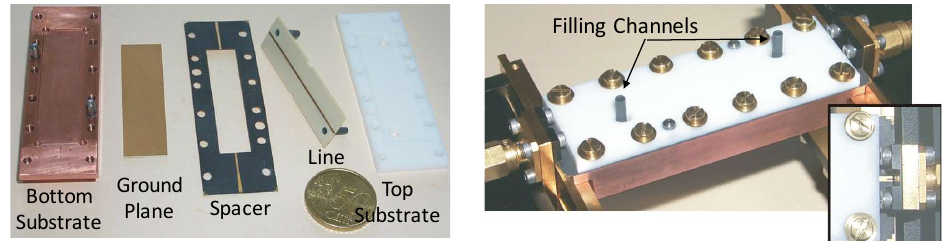
Figure 20. Realized broadband inverted microstrip line (IMSL) phase shifter for frequencies from 1.125 up to 35 GHz. Different parts ( left ) and assembled phase shifter with filling channels ( right ) [47,186].